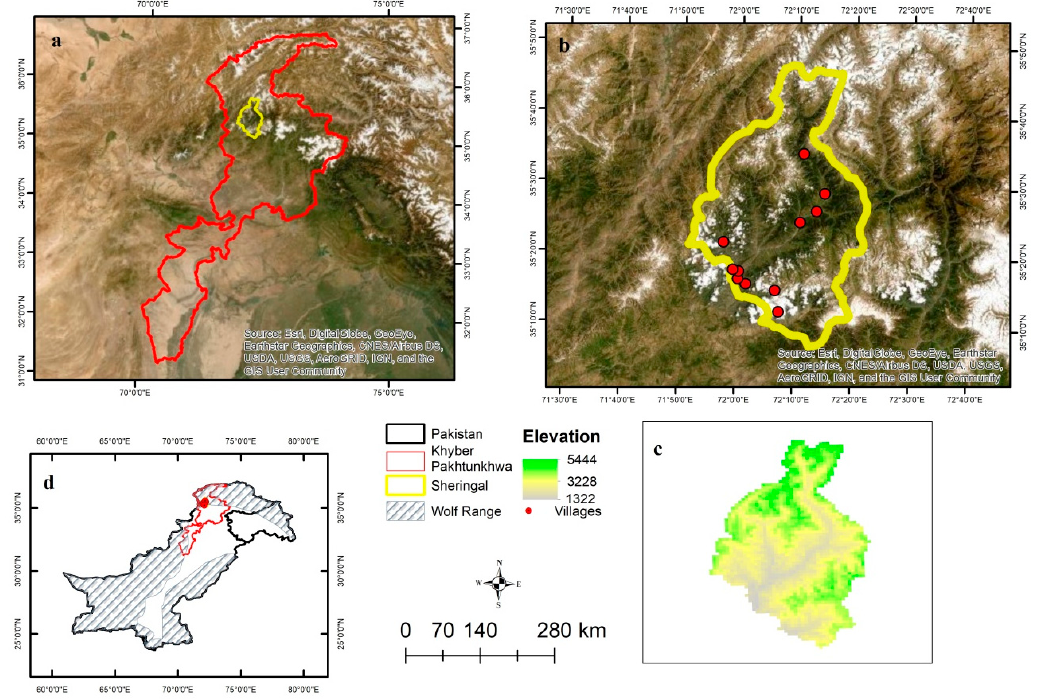
Figure 1. Location of our study area. Location of the study area ( a ), major villages of the study area ( b ), elevation range of the study area ( c ), and the distribution range of the grey wolf across Pakistan ( d ).